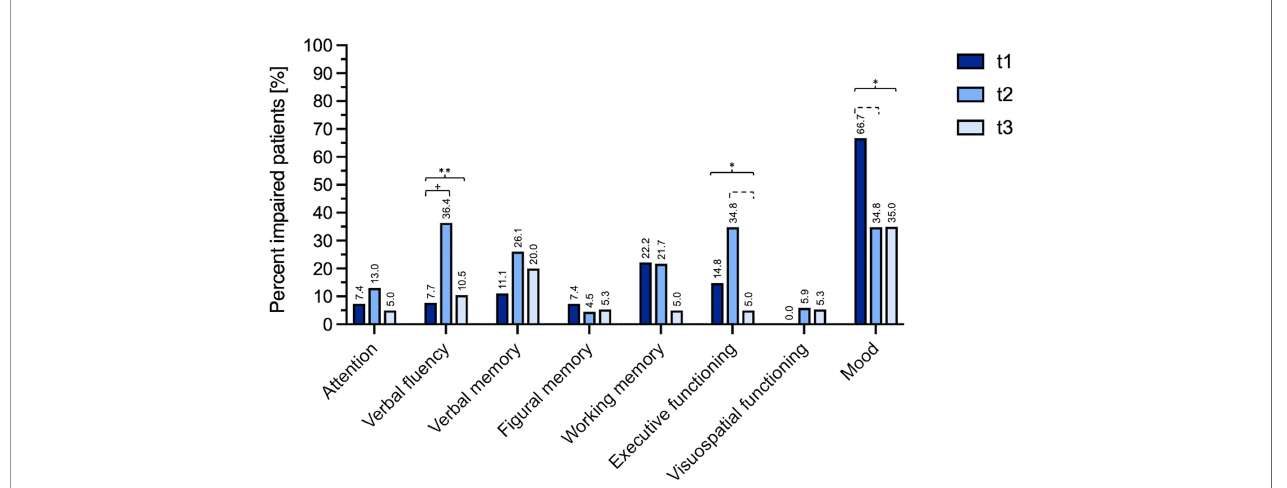
FIGURE 1 | Percent of impaired patients at T1 (preoperatively), T2 (after a median follow-up period of 4.1 months) and T3 (after a median follow-up period of 18.3 months). Long brackets mark results of the Cochran ’ s analysis (*=p < 0.05, **=p < 0.01), small brackets mark the post-hoc tests performed for serial follow up data (+=p < 0.05, dashed bracket p < 0.1). Complete data with Cochran Q ’ s and post-hoc tests for all domains is available as supplementary material ( Supplementary Table 1 ).